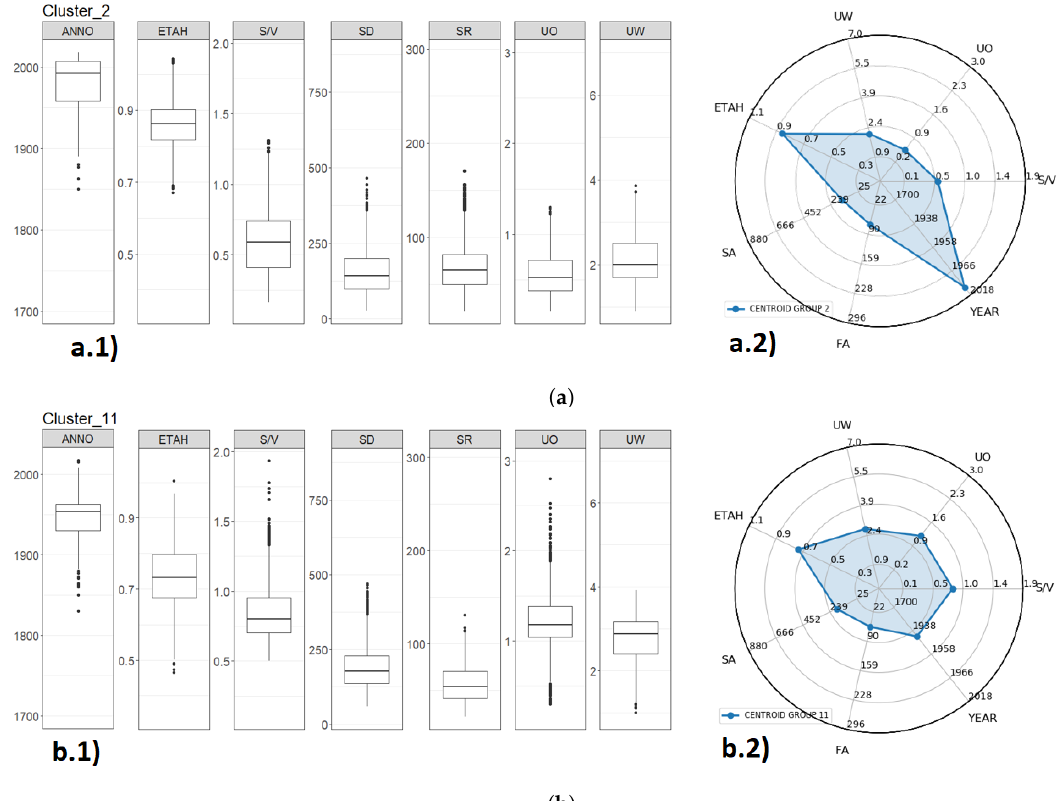
Figure 10. Boxplot distribution (a.1 and b.1) and radar chart visualization (a.2 and b.2) for Clusters 2 and 11: ( a ) group of high performance buildings; and ( b ) group of low performance